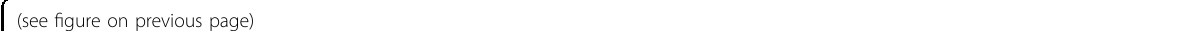
Fig. 1 Landscape of dynamic protein expression during human pre-implantation development. a Representative microscopy images of a human mature (MII) oocyte (5 samples were analyzed) and early embryos at the following stages: zygote (2 pronuclear (2PN) embryo) (5 samples), 2-cell (4 samples from 2 embryos), 4-cell (13 samples from 3 embryos), 8-cell (9 samples from 1 embryo), morula (12 samples), blastocyst (10 samples). Scale bar, 50 µm. b Box plot showing the number of proteins detected in single oocytes or blastomeres. Median values are shown. c Proteomic PCA of single oocytes and blastomeres during human pre-implantation development. d Number of DEPs (fold change > 2 or < 0.5) at each stage compared with the other stages. e Heatmap of stage-speci fi c proteins including their normalized expression levels (Z-score value), marker proteins (at right), protein numbers (at right) and speci fi c GO-terms (at left). *** represents GO terms of ‘ RNA polymerase II transcriptional pre-initiation complex assembly ’ and ‘ regulation of translation initiation in response to endoplasmic reticulum stress ’ at the morula stage. f Heatmap of corresponding maternal-translated (clusters 8 – 11) and zygotic-translated proteins (cluster 12). Numbers of proteins are shown in brackets. g GO analysis of maternal- translated proteins. Numbers of proteins participated in the terms are shown in brackets. h GO analysis of zygotic-translated proteins. Numbers of proteins participated in the terms are shown in brackets. i Histogram showing the number of de novo expressed ‘ prime-state genes ’ at each stage. Percentages of de novo expressed ‘ prime-state ’ proteins to all expressed proteins are shown in brackets. j Identi fi cation of biological processes (BP) in embryo development based on analysis of the conserved proteins. Square nodes represent BP terms; circular nodes represent related